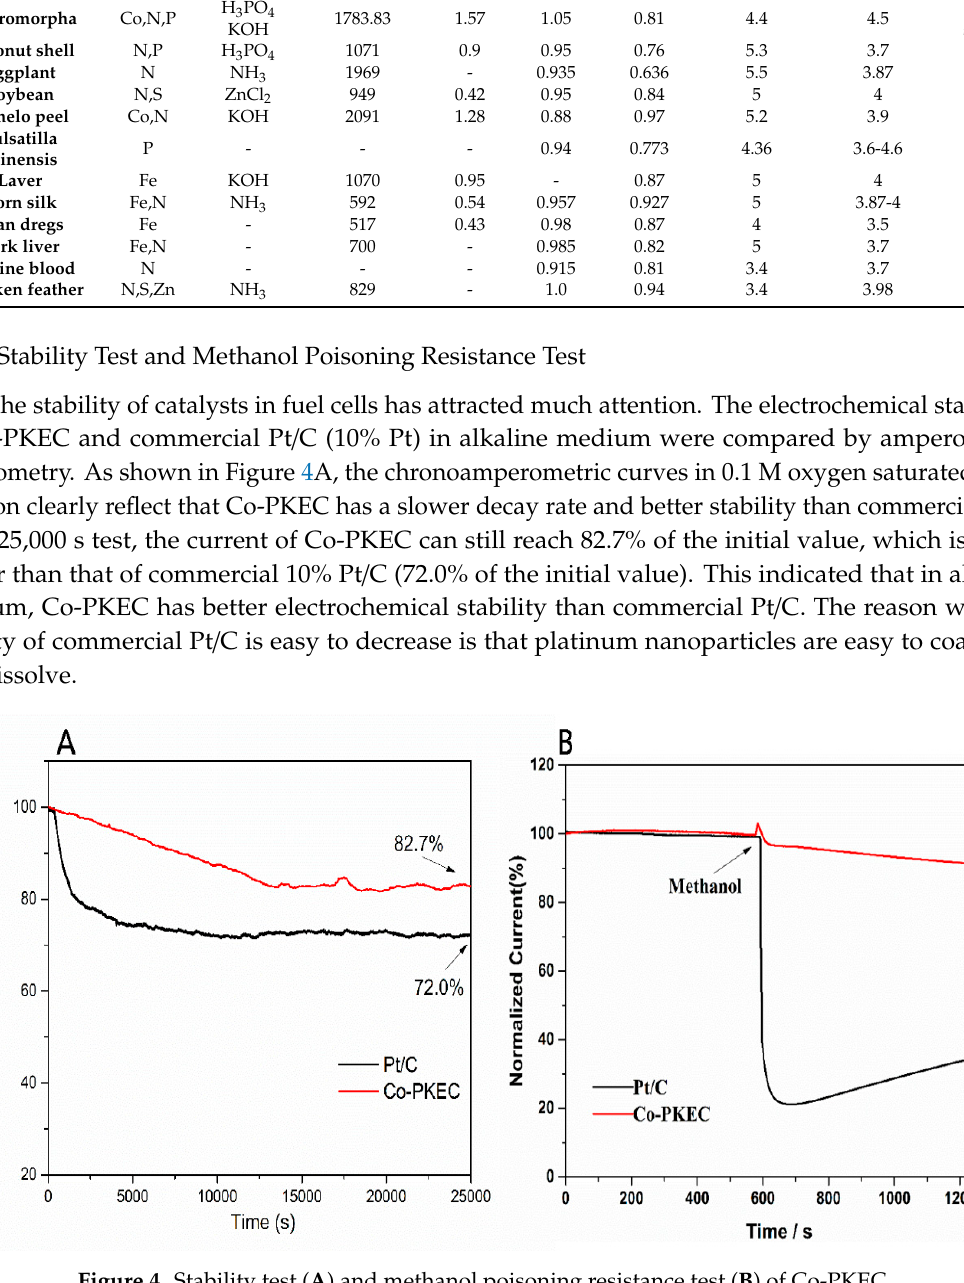
Figure 5. SEM of Co-PKEC with different magni fi cation. To further understand the pore structure, N 2 adsorption and desorption isotherms and pore size distribution of catalysts PKEC and Co-PKEC are shown in Figure 6. The variation of specific surface area and pore structure of samples before and after Co was analyzed by N 2 adsorption-desorption